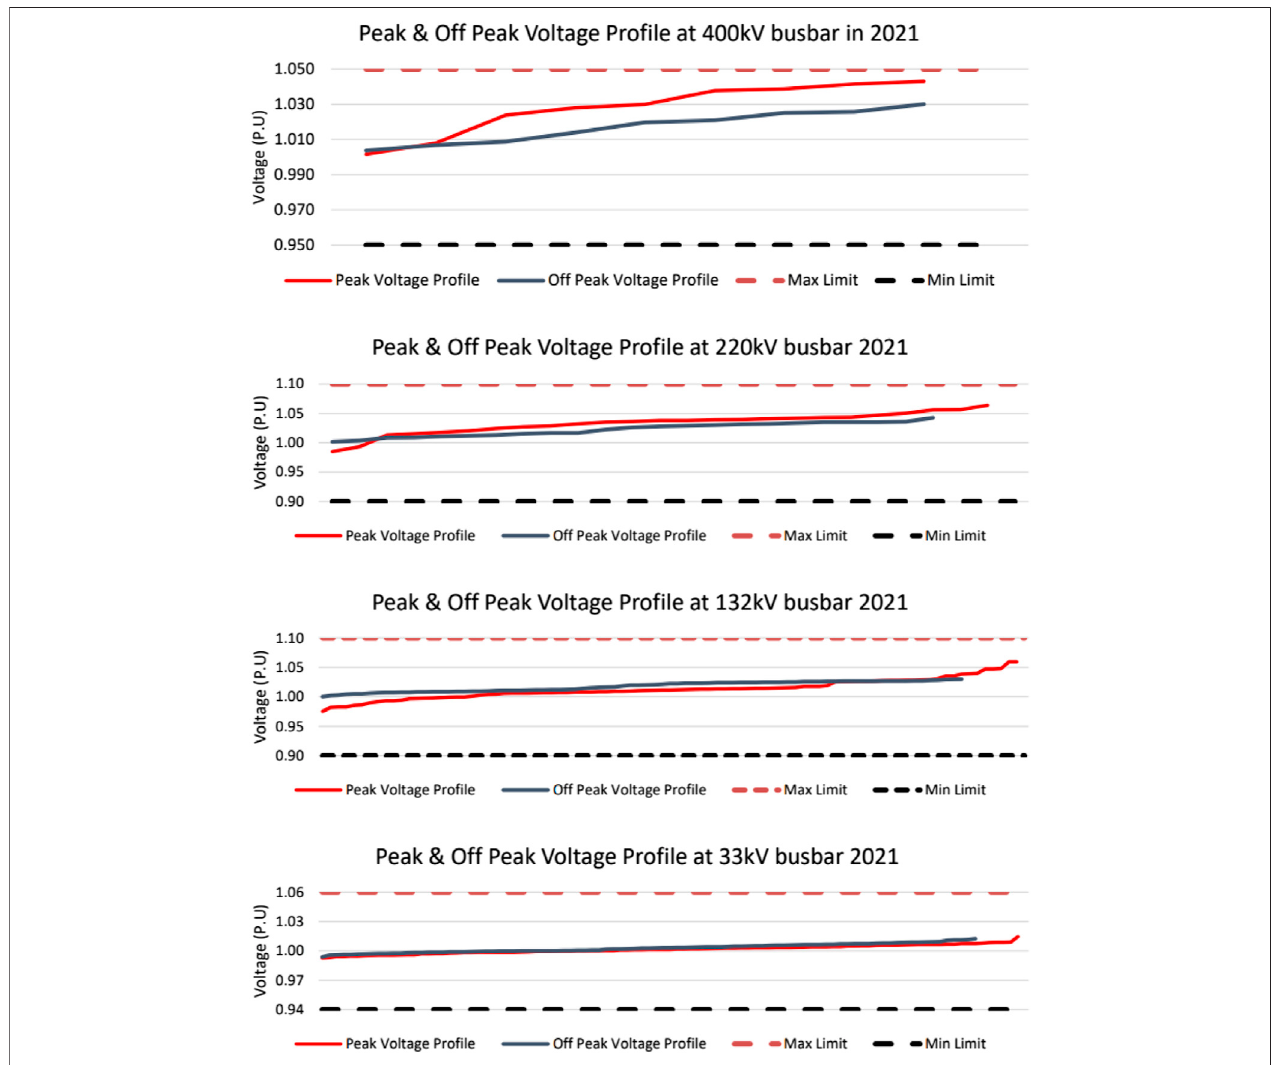
FIGURE 3 | MIS peak and off-peak voltage pro fi les at different power grids in